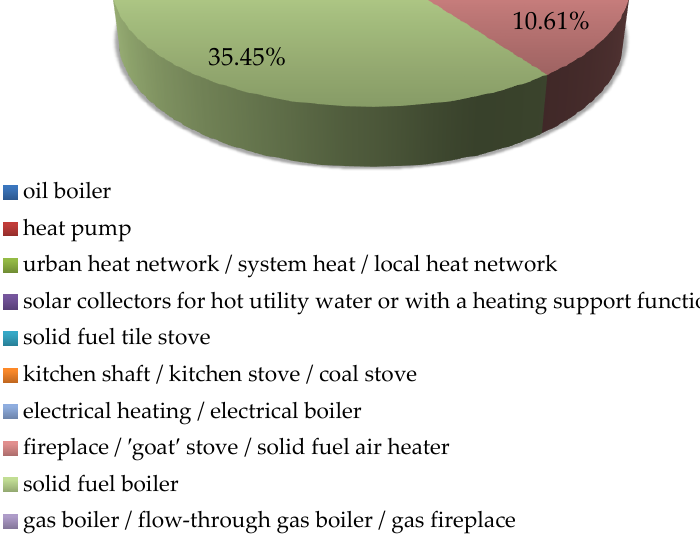
Figure 8. Sources of heat used in residential buildings. Own research based on [60].